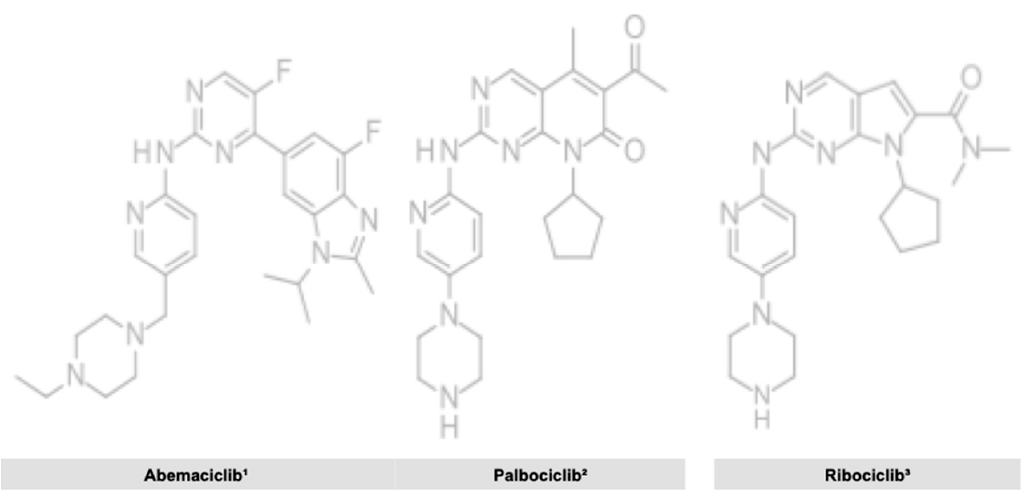
Figure 1. Chemical structure of the different CDK inhibitors. 1 . Abemaciclib [31]. 2 . Palbociclib [32].